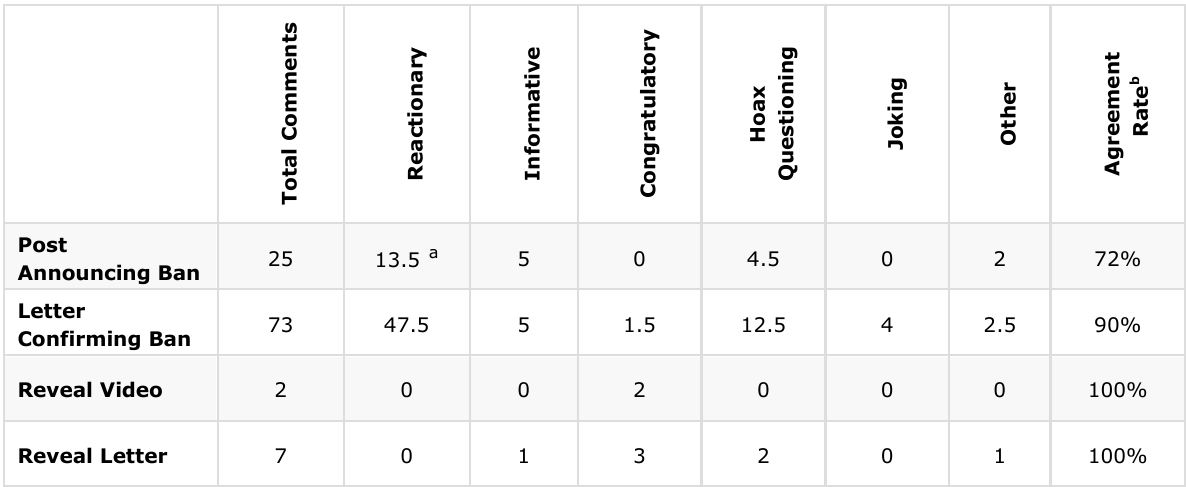
Categorization of Comments: Number of Comments